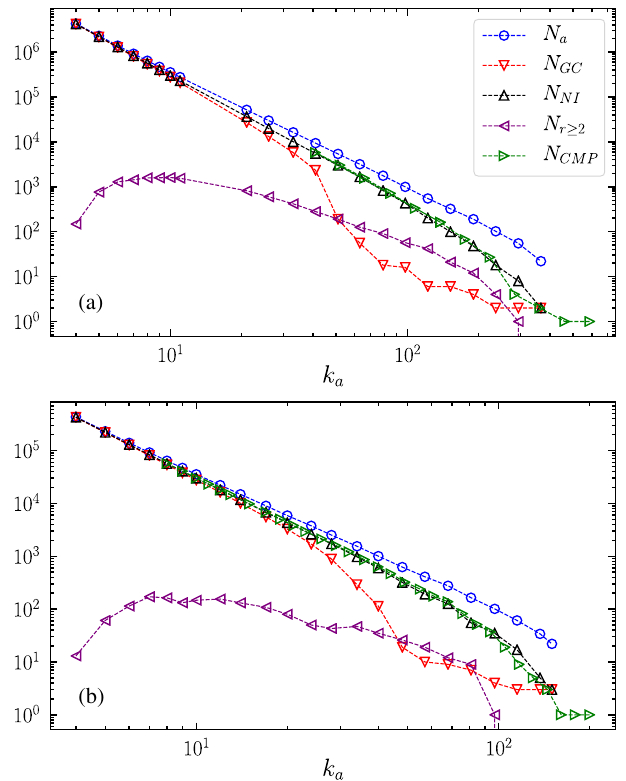
FIG. 2. Dependence on k of the number N of active nodes, a a the number N of nodes in the DOP giant component, the GC number N of nonisolated nodes, the number N of isolated r ≥ 2 NI of nodes in the nodes with range r ≥ 2 , and the number N CMP CMP giant component. Results are for power-law networks with γ ¼ 3 . 5 , k 3 , and size N ¼ 10 7 (a) and N ¼ 10 6 (b), min ¼